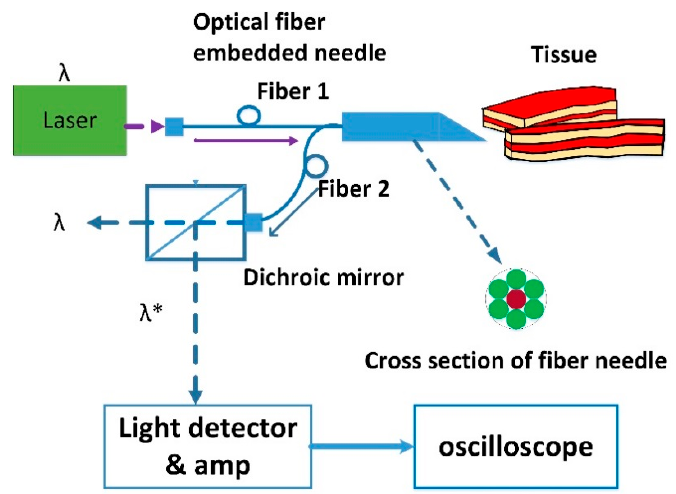
Figure 2. The fiber needle contains seven optical fibers. The one in the center (Fiber 1) which is marked by red color is for light emission. The rest fibers marked in green color are for receiving optical signal from tissues. Laser light with wavelength λ (405 nm) is coupled into Fiber 1. The reflective light from tissue is guided to the dichroic mirror (Delta DCLP425) through Fiber 2. The reflective light is partially transmitted with the same wavelength λ through the mirror into the air and partially reflected by the mirror with fluorescent light of wavelength λ *. The λ * is a band of wavelengths which is greater than wavelength ( λ ).